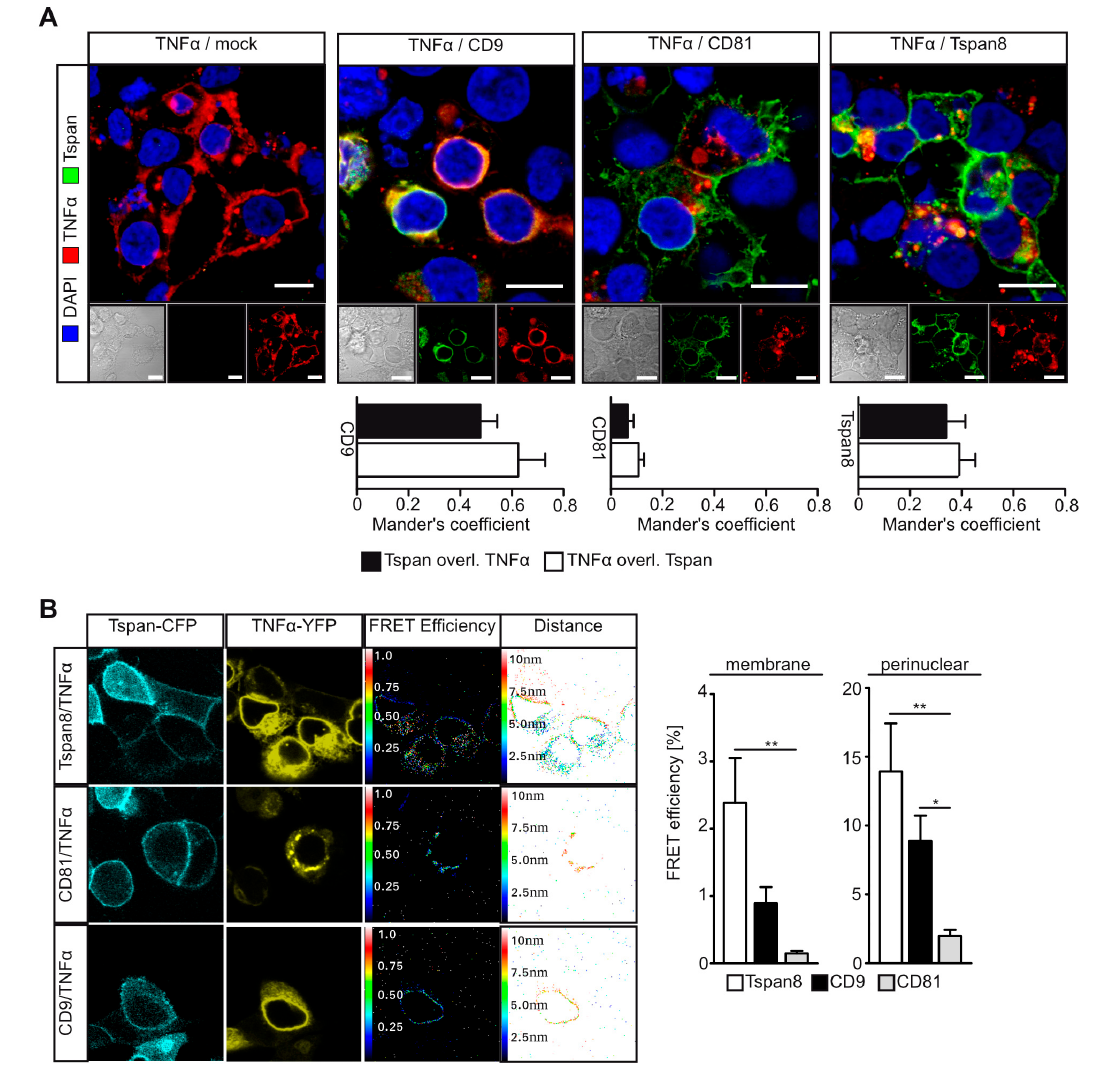
Figure 4. Tspan8 and CD9 interact with TNF α . ( A ) TNF α co-localizes with CD9 and Tspan8 at different subcellular compartments in transfected HEK293T cells as assessed by immunofluorescence. ( B ) Specific interaction of TNF α with the indicated Tspans in transfected HEK293T cells was assessed by FRET microscopy. Data are represented as mean ± s.e.m. n = 9 HPF images ( A ), n = 3 independent experiments ( A,B ), * p <0.05, ** p < 0.01, Kruskal–Wallis with Dunn’s post-hoc test ( B ).